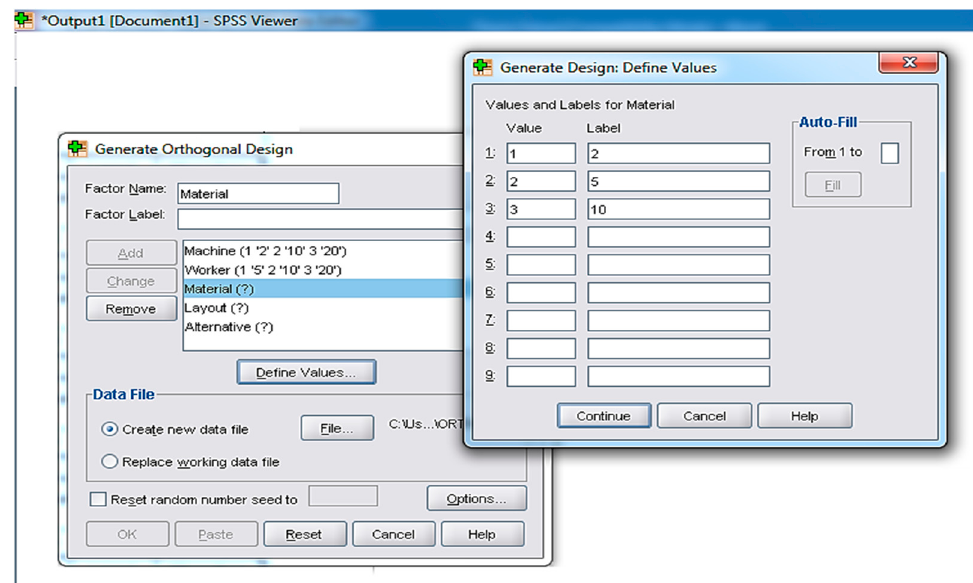
Figure 20. Setting levels for each of the factors in the orthogonal design.